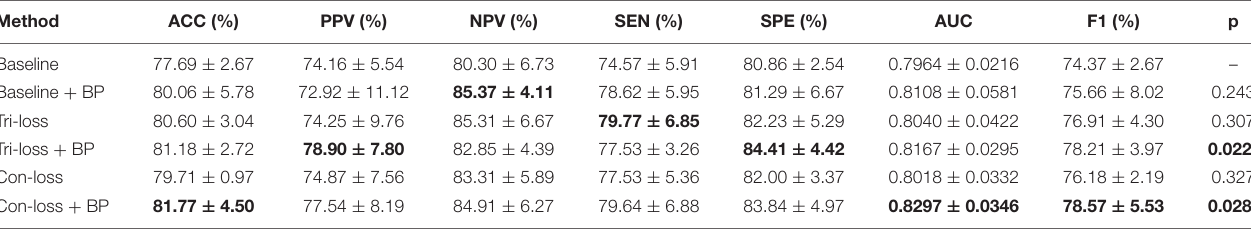
TABLE 5 | Results of the ablation studies of BP module and metric learning loss for LMCI vs. AD classification (Mean ± Standard Deviation).